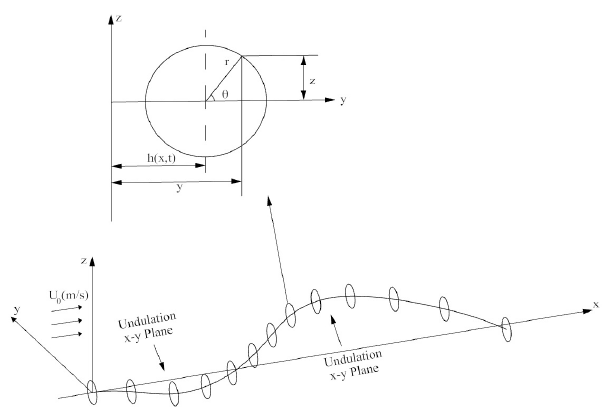
Figure 1. Analytical formulation of the anguilliform swimming motion in Cartesian and polar coordinates.